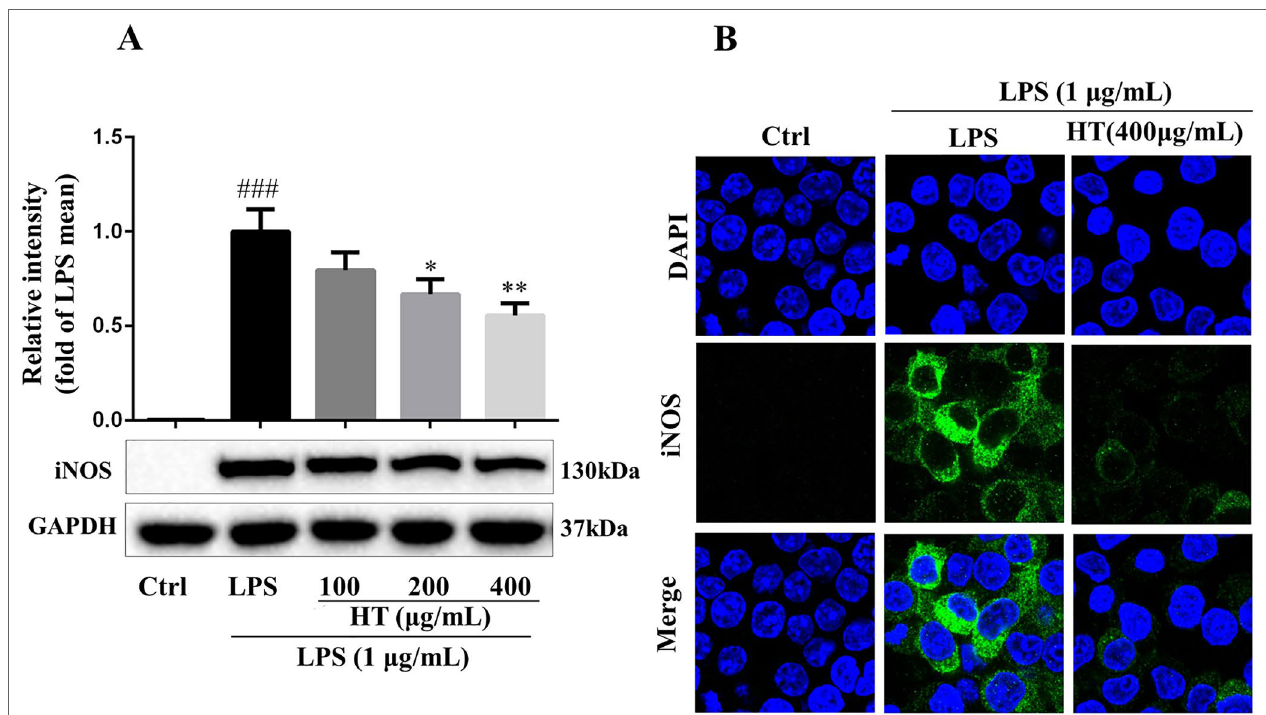
FIGURE 5 | HT reduced inducible nitric oxide synthase (iNOS) expression in LPS-induced RAW264.7 cells. The cells were pretreated with HT extract at indicated concentrations in six-well plate for 1 h before stimulation with LPS (1 μg/ml) for 12 h; then, the expression of iNOS was examined by western blotting (A) and immunofluorescence staining (B) . Data are presented as the mean ± SD ( n = 3). ### P < 0.001 vs. the Ctrl group. * P < 0.05, ** P < 0.01 vs. the LPS